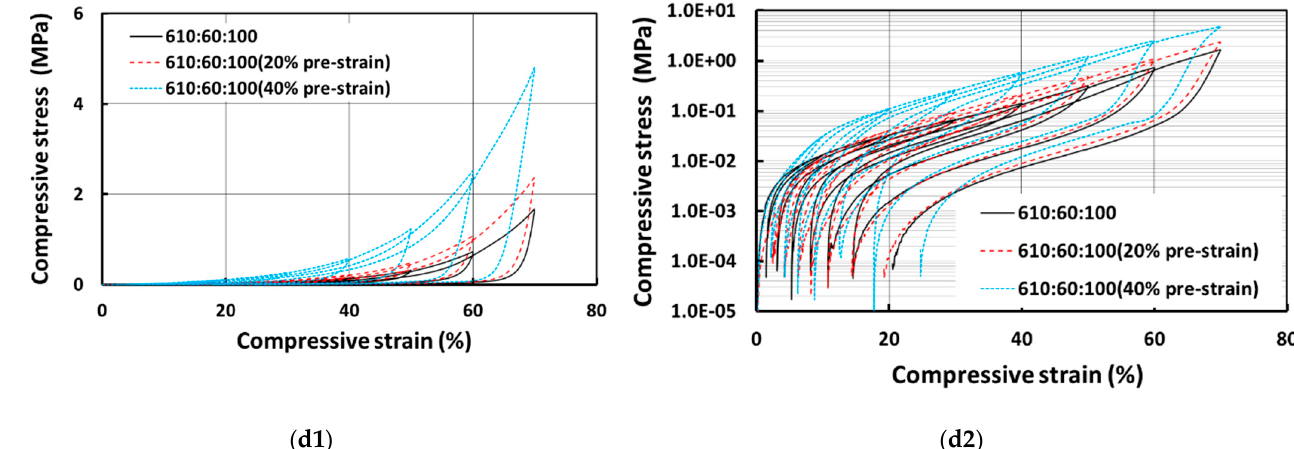
Figure 13. Compressive stress vs. strain of E610 SMH samples with 0%, 20% and 40% pre-strains; ( a1 ) for samples with 70% silicone, 30% PCL and 50% wetting hydrogel and its corresponding logarithmic plot of stress in ( a2 ); ( b1 ) for samples with 70% silicone, 30% PCL and 100% wetting hydrogel and its corresponding logarithmic plot of stress in ( b2 ); ( c1 ) for samples with 60% silicone, 40% PCL and 50% wetting hydrogel and its corresponding logarithmic plot of stress in ( c2 ); and ( d1 ) for samples with 60% silicone, 40% PCL and 100% wetting hydrogel and its corresponding logarithmic plot of stress in ( d2 ).